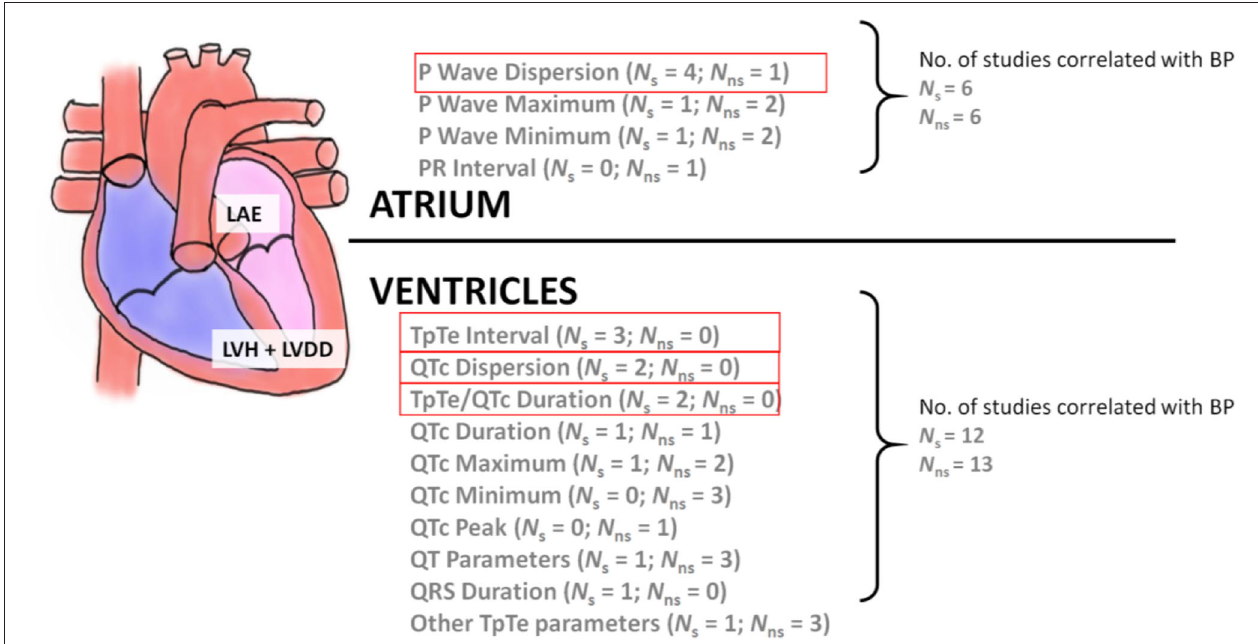
FIGURE 3 | The relationship between atrial and ventricular ECG wave features with BP. LAE, left atrial enlargement; LVH, left ventricular hypertrophy; LVDD, left ventricular diastolic dysfunction. Note that N s stands for the number of studies of statistical significance ( p < 0.05) while N ns stands for the number of studies of non-statistical significance. The four features highlighted in red show features that have two or more studies with statistically significant results.